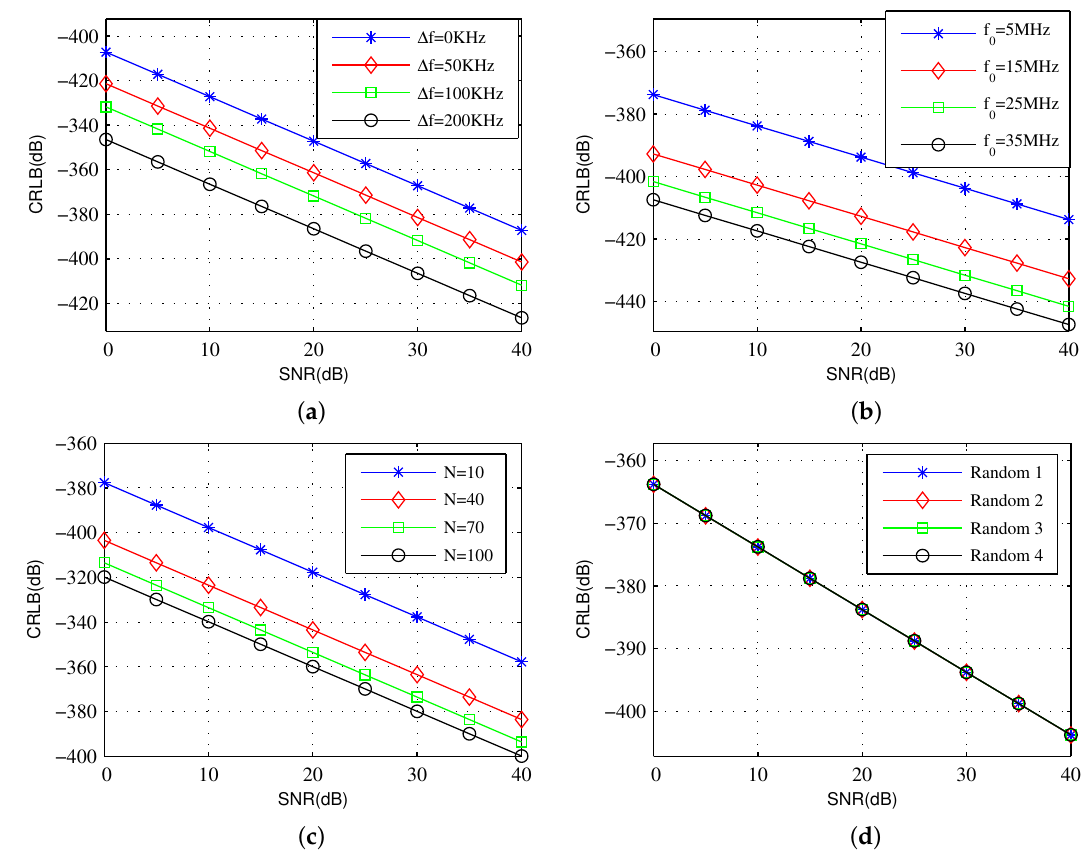
Figure 2. CRLB comparison with different parameters. ( a ) different frequency step ; ( b ) different initial carrier frequency; ( c ) different frequency number; ( d ) different sparse frequency combination.